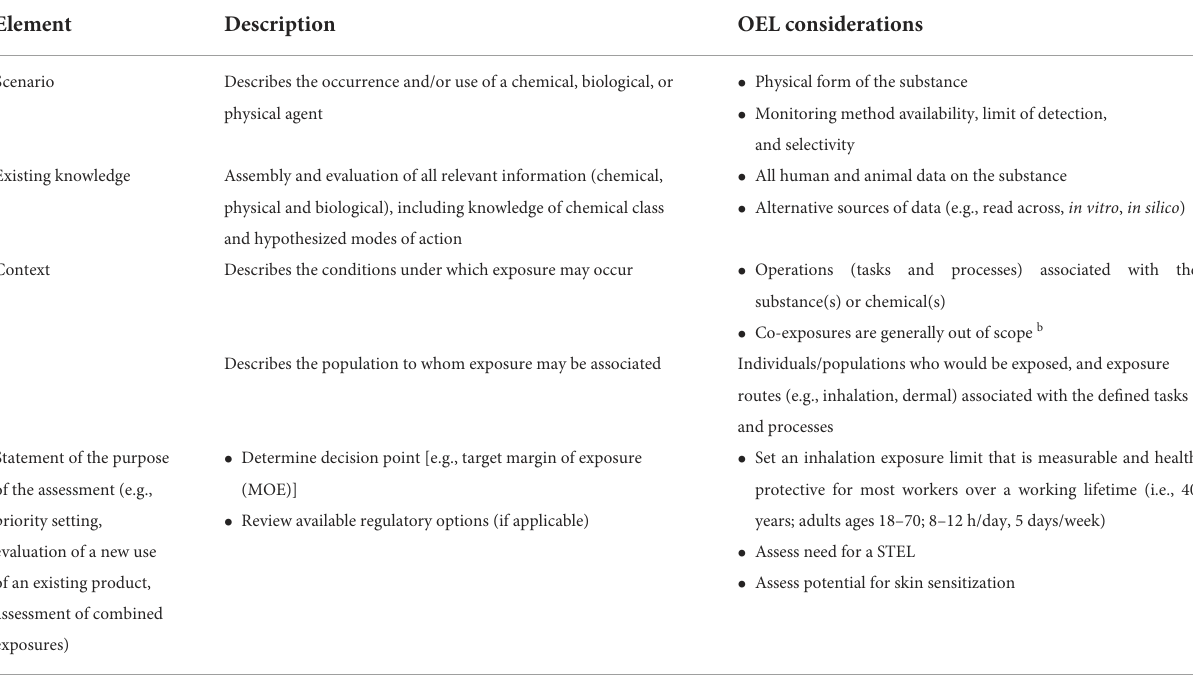
TABLE 1 Problem formulation considerations a